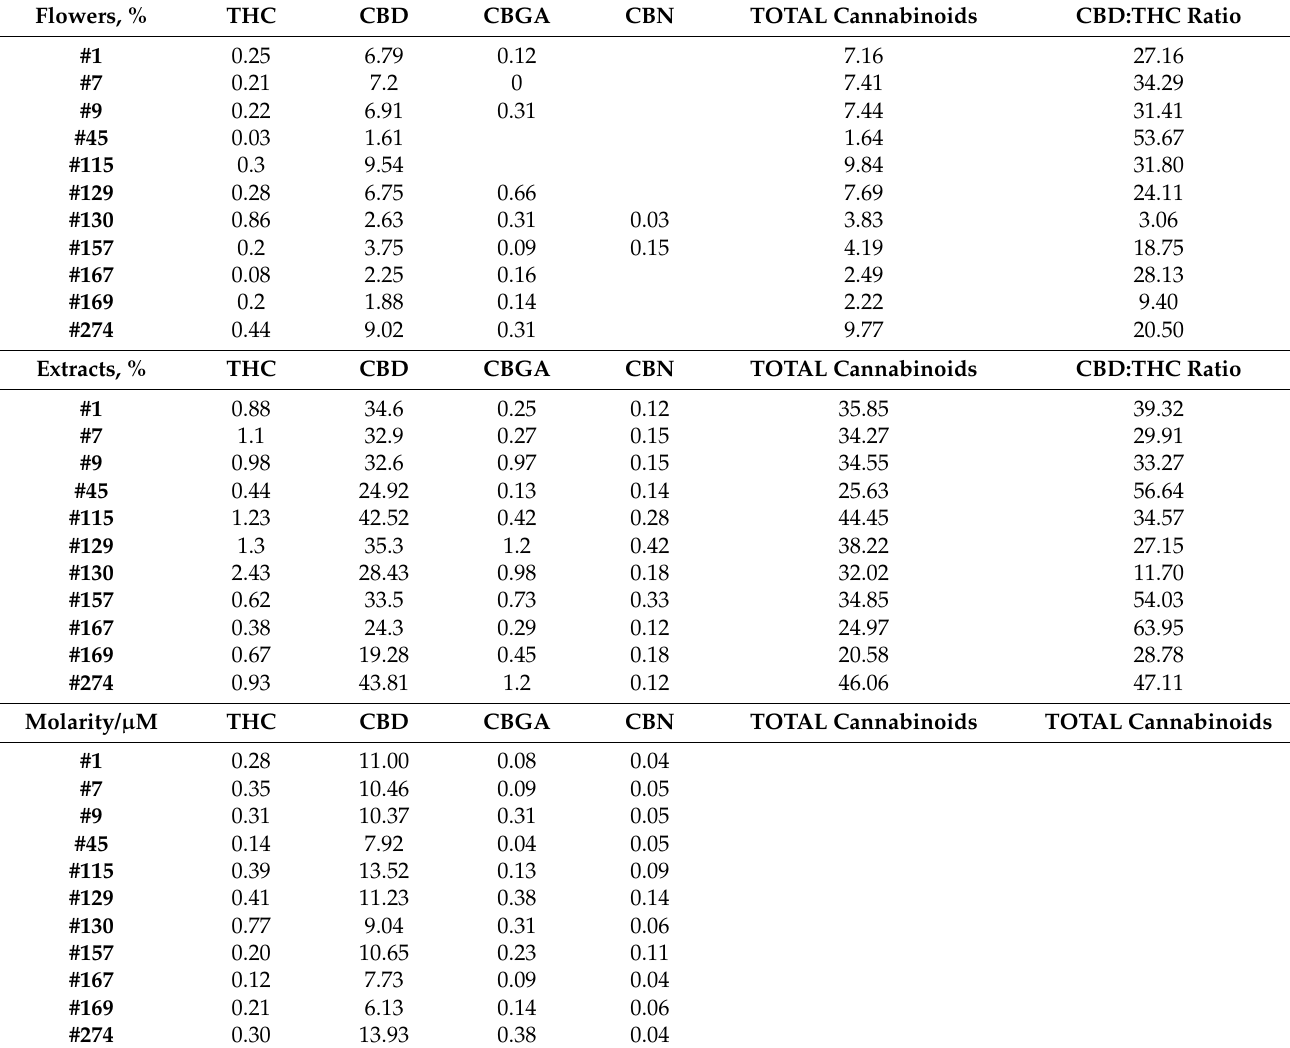
Table 1. Level of single and total cannabinoids in the flowers and extracts of selected C. sativa